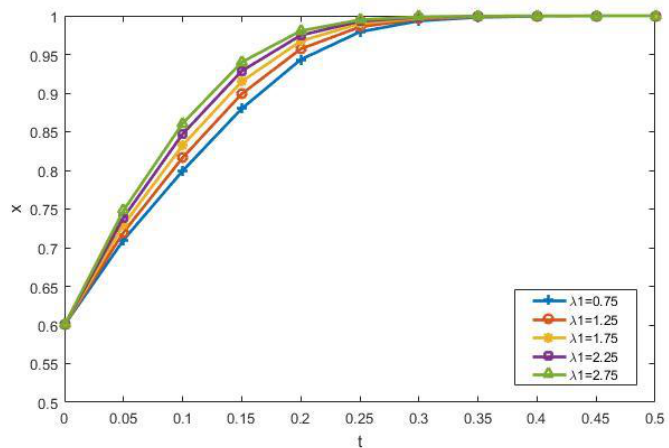
Figure 11. The impact of λ 1 on the evolutionary results.